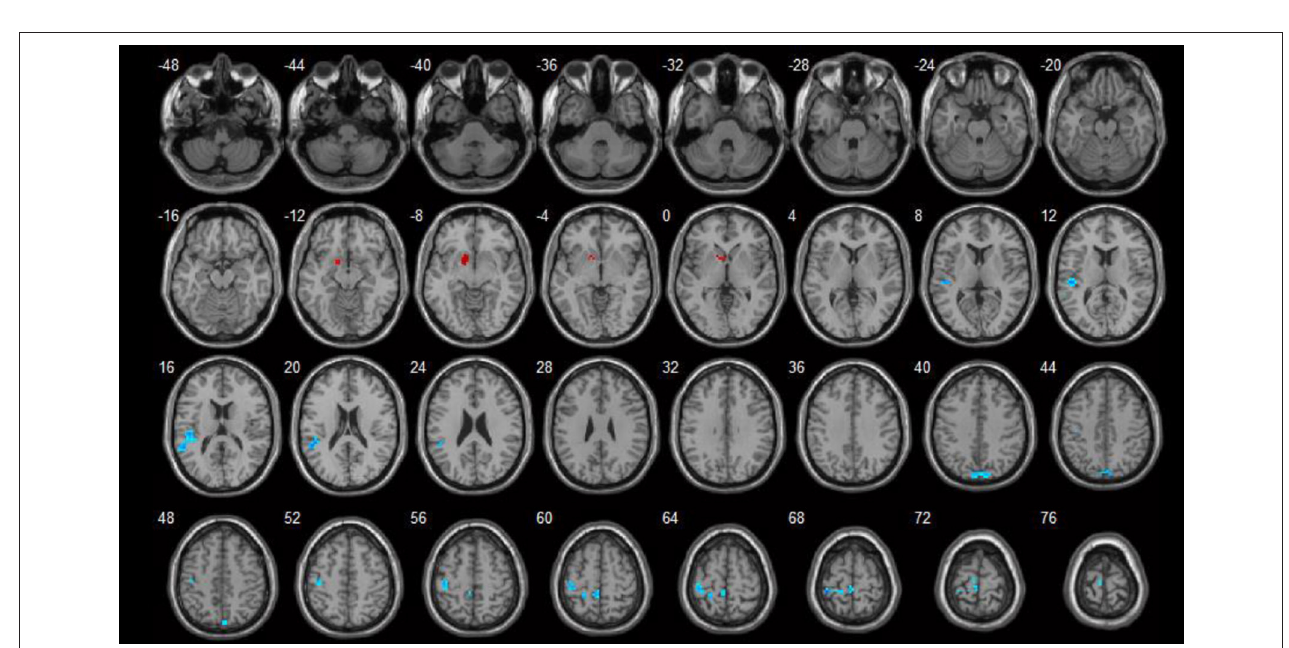
FIGURE 3 | Correlations between ReHo values and HAMA scores ( p < 0.05). Blue spots show areas with negative correlations with HAMA.